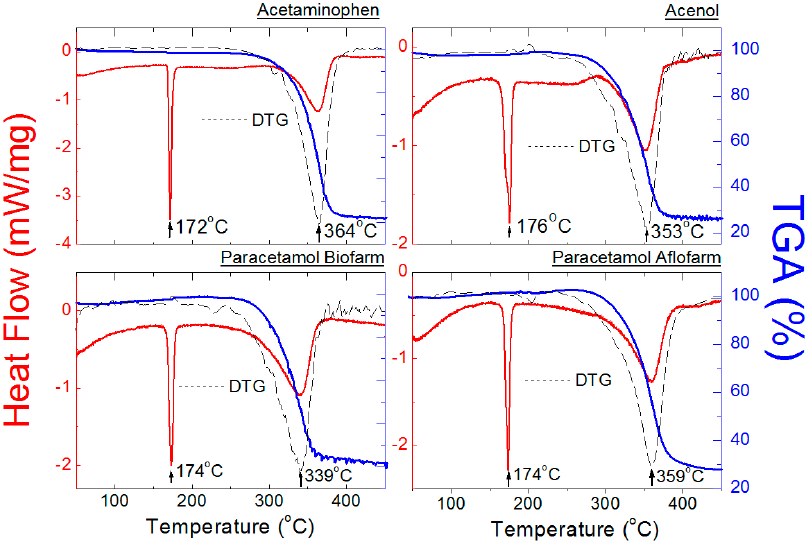
Figure 10. DSC and TGA/DTG curves of ACP and the drugs containing ACP Acenol, Paracetamol Biofarm, Paracetamol Aflofarm.